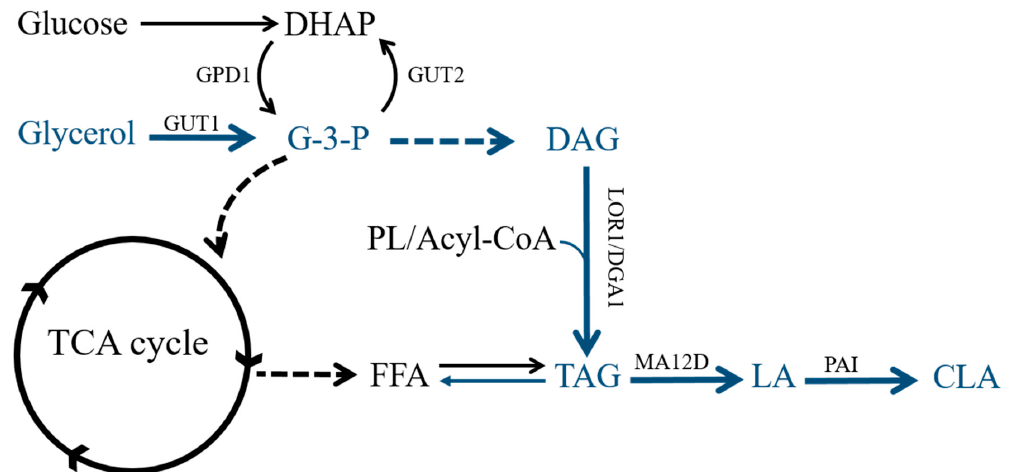
Figure 1. Overview of the lipid metabolism pathway for Yarrowia lipolytica . DHAP: dihydroxyacetone phosphate; G3P: glyceraldehyde 3-phosphate; DAG: diacylglycerol; PL: phospholipid; TAG: triacylglycerol; FFA: free fatty acids; LA: Linoleic acid; CLA: conjugated linoleic acid; GPD1: NAD + -dependent glycerol-3-phosphate dehydrogenase; GUT1: glycerol kinase; GUT2: glycerol-3-phosphate dehydrogenase; DGA1: diacylglycerol transferase; MA12D: Mortierella alpine Δ 12 desaturase; PAI: Propionibacterium acnes isomerase.